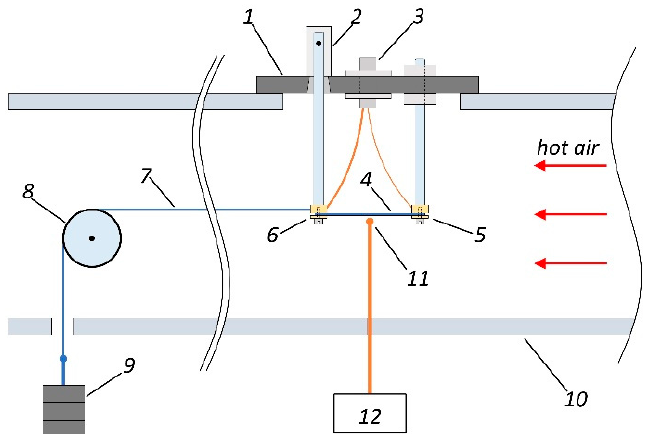
Figure 2. Scheme of the measuring cell placement in the duct. 1—measuring cell base; 2—swivel of